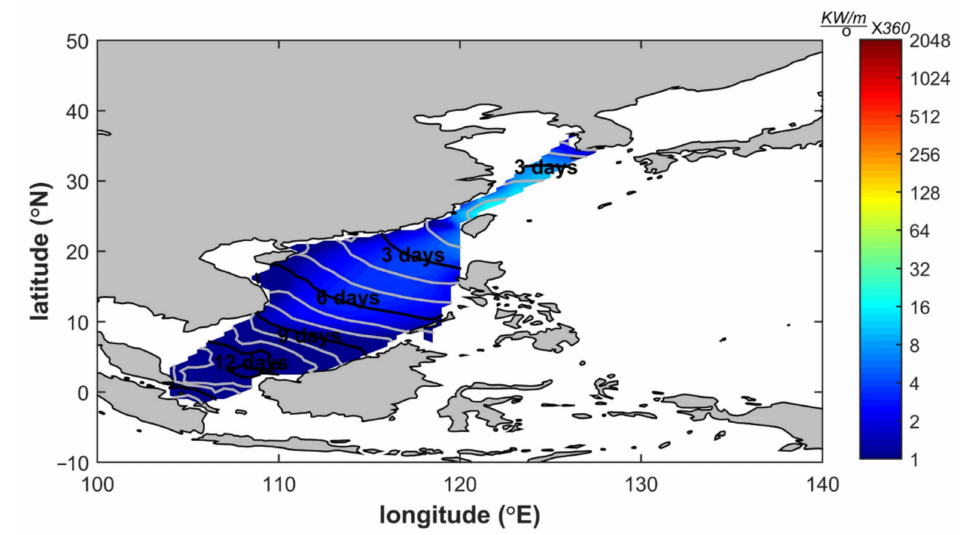
Figure 4. Mean effective energy flux obtained using ESTELA method from 1980 to 2004 in the west of